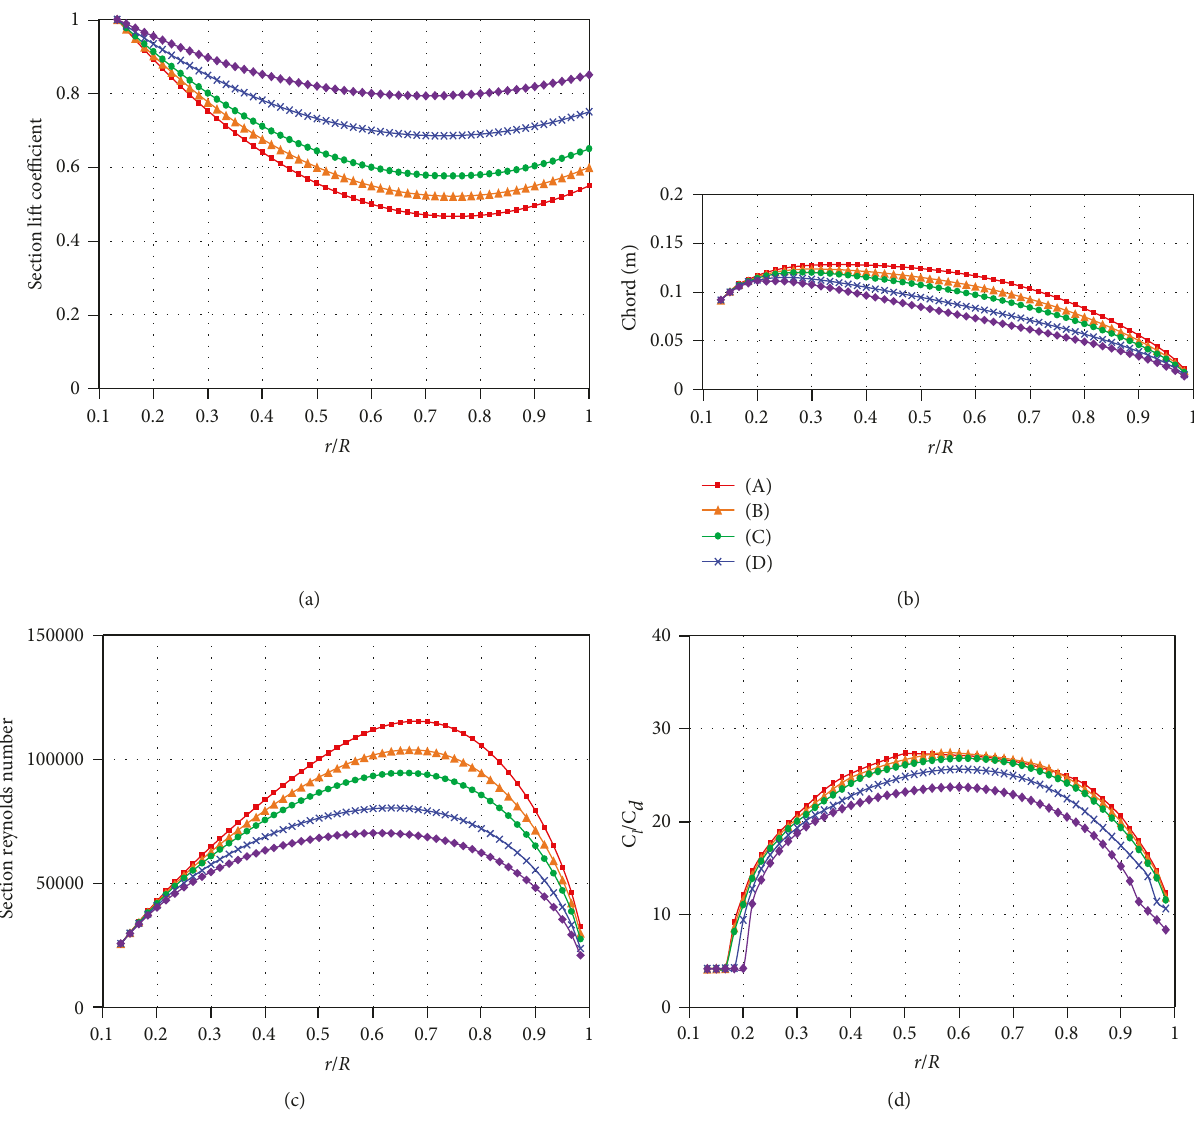
Figure 6: E ff ect of lift coe ffi cient distribution on